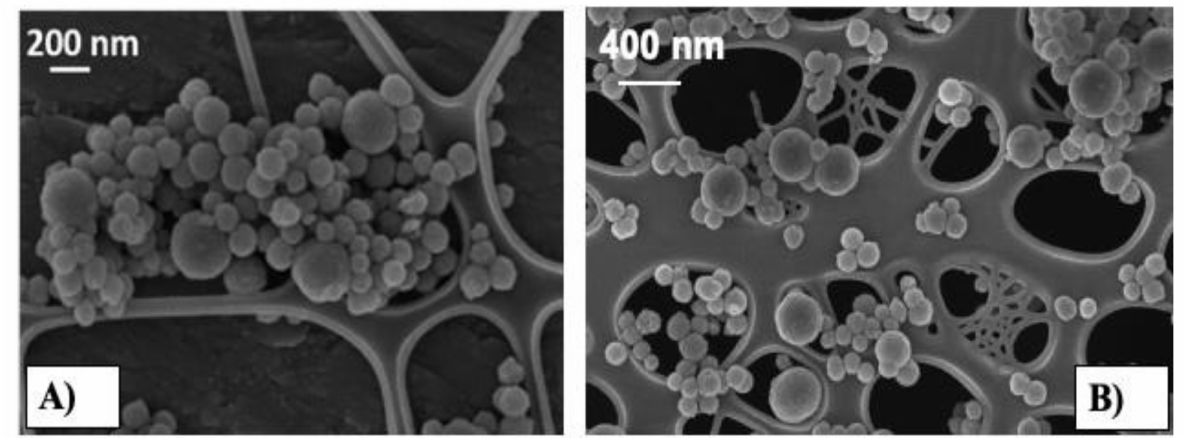
Figure 2. FE-SEM images of ( A ) Cu_SG_CAC_Ibu and ( B )